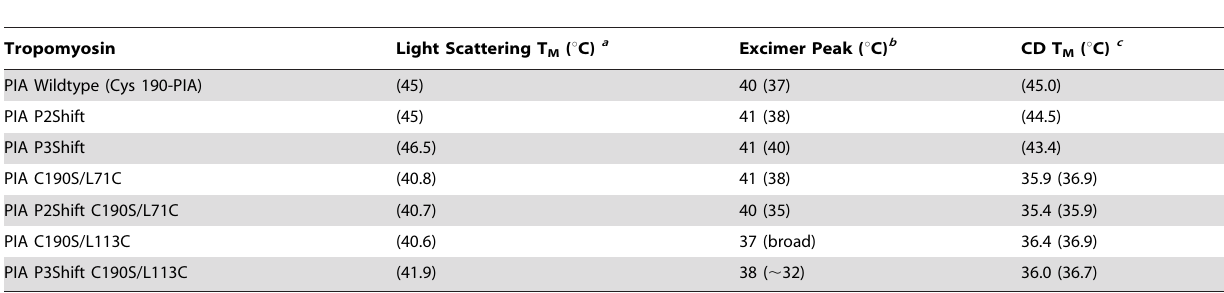
Table 3. The T M s of the light scattering, PIA excimer fluorescence, and unfolding.